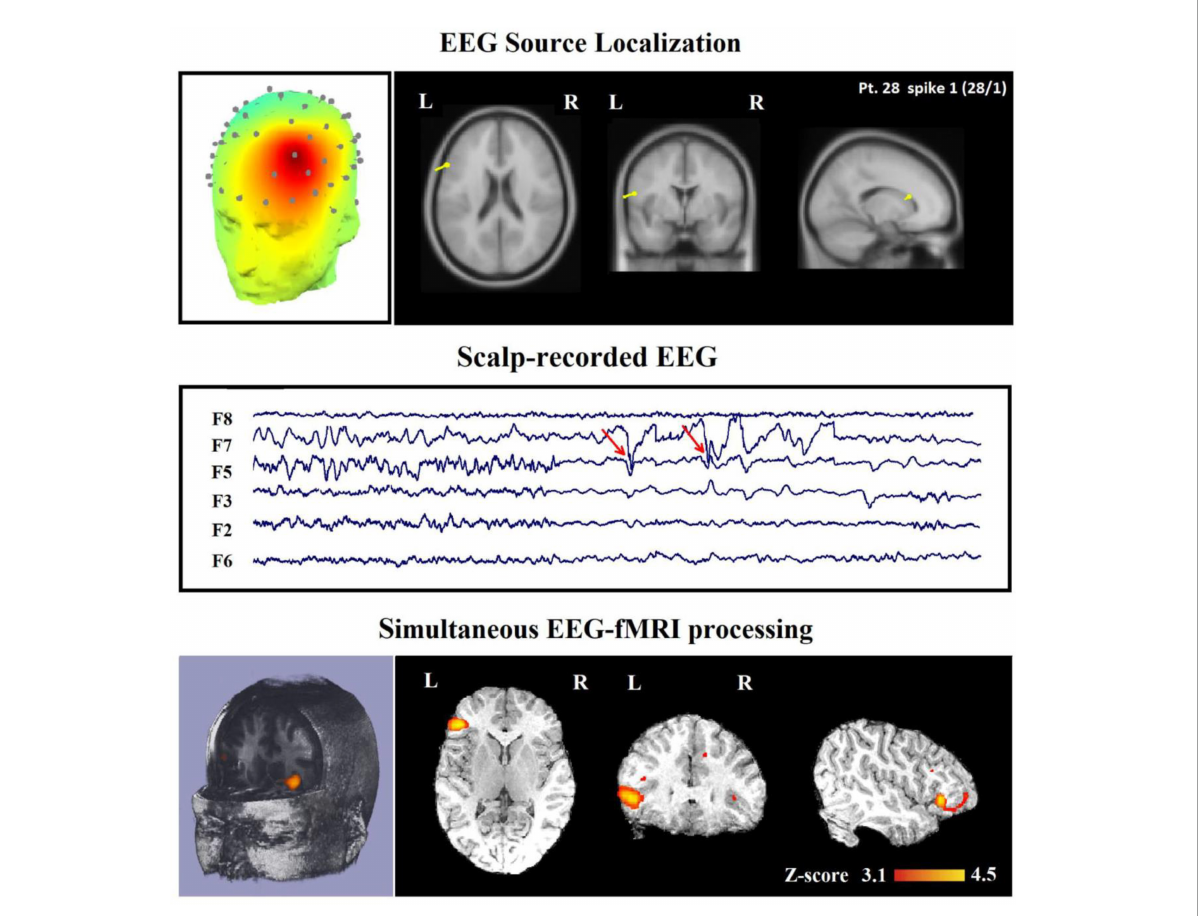
FIGURE11 Source analysis using EEG-informed fMRI approach in a 26-year-old woman with frontal lobe epilepsy (FLE) which demonstrates a neocortical activation in the inferior frontal gyrus. Top, the component identified on scalp EEG is shown which is located in the left frontotemporal lobe (left) and the dipole localization of the identified generator in deep brain structures (right). Middle, scalp recorded EEG with marked events on F3, F5, and F7. Bottom, Localization of the generator applying simultaneous analysis of EEG-fMRI. The active area is marked with a yellow-red color (Ebrahimzadeh et al.,